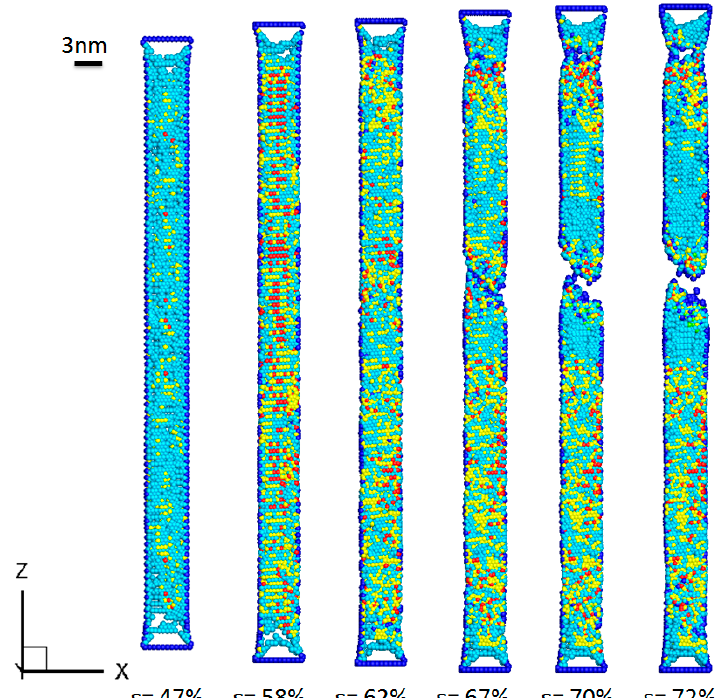
Figure 7. The lateral view of the cross-section at different strain levels ( ε = 47–72%). (blue: incomplete nanostructure with CN < 4; cyan: CN = 5 meta-stable phase with CN = 5; yellow: Si-II phase with CN = 6; red: high pressure phase with CN > 6).